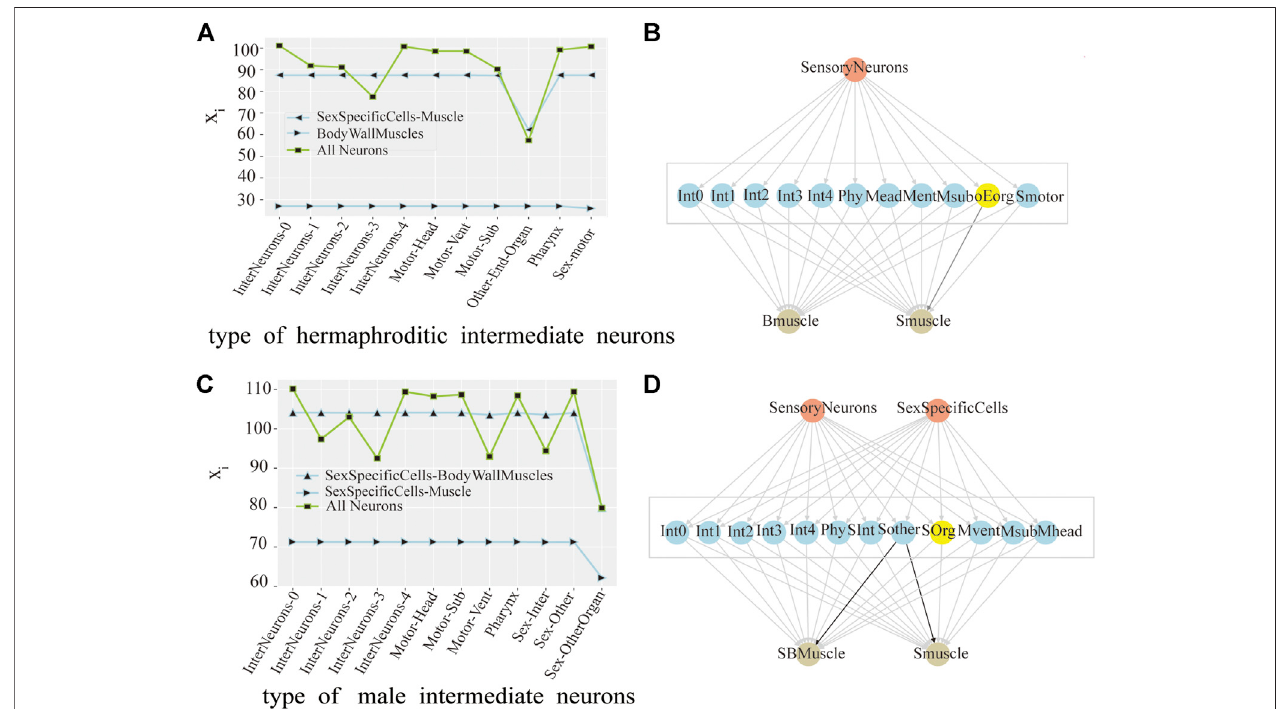
FIGURE 2| Control analysis of neuron group in hermaphrodite and male C.elegans . (A) Line chart of the change ofthe averageactivity by neuronalperturbation of the each interneurons group in hermaphroditic C.elegans . (pink as the input neuron, blue as the intermediate neuron, and yellow as the output neuron, same as below). (B) Model of the interneurons group with core control in hermaphroditic C.elegans . The groups of interneurons with maximum control were marked with yellow color, same as below. (C) Line chart of the change of the average activity by neuronal perturbation of the each interneurons group in male C.elegans . (D) Model of the interneurons group with core control in male C.elegans